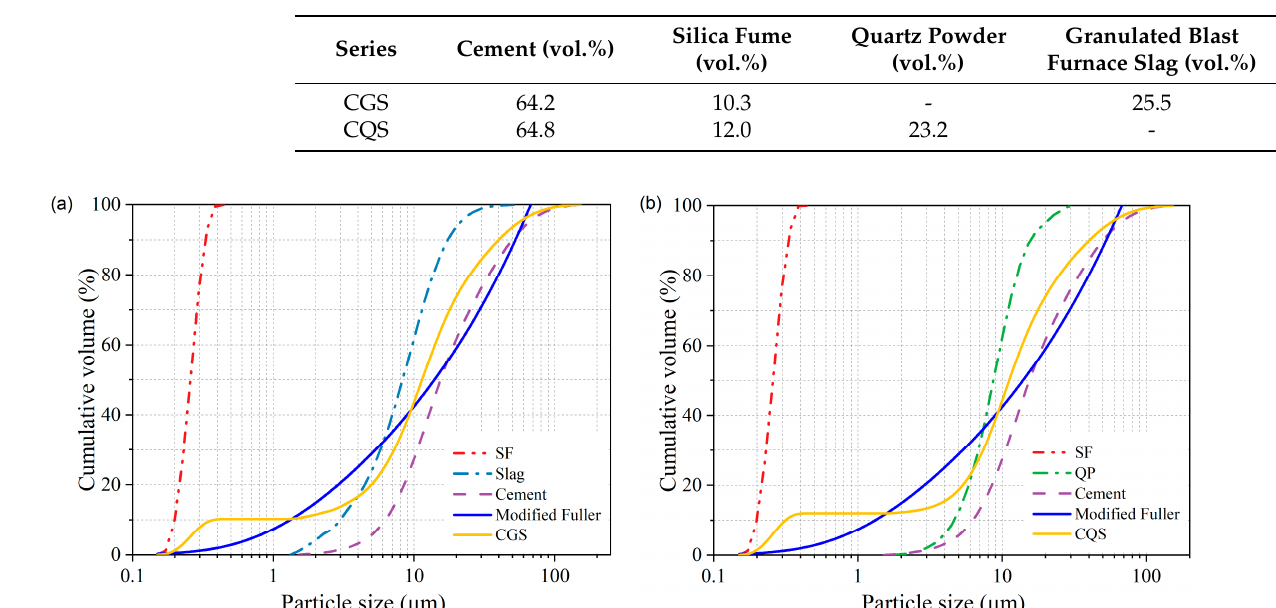
Figure 2. Particle size distribution of cementitious material: ( a ) CGS system; ( b ) CQS system.